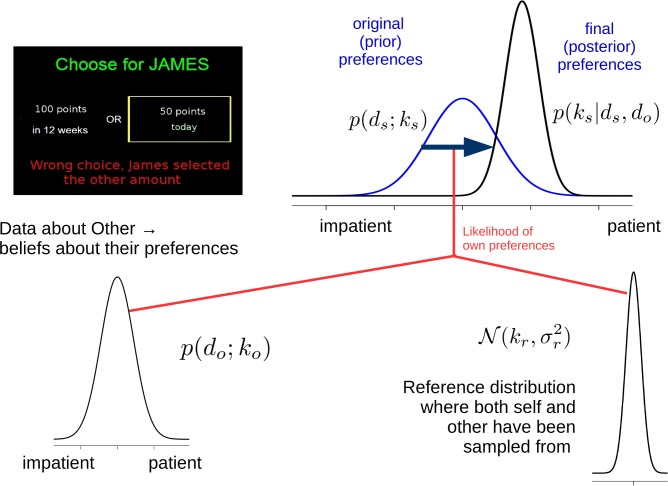
Uncertainty-relevance model of preference shift.Before information about the ‘other’ is seen, beliefs about the reference distribution are uninformative and so the original beliefs about the self are proportional to the likelihood p(ds; ks). Once data do about the other are seen, the likelihood of ko combines with the conditional probabilities that ks and ko as they are drawn from the reference distribution; this combination multiplies the beliefs about the self to yield the posterior (shifted) ks. This is a schematic representation of Eq 5 (see e.g. its penultimate line).